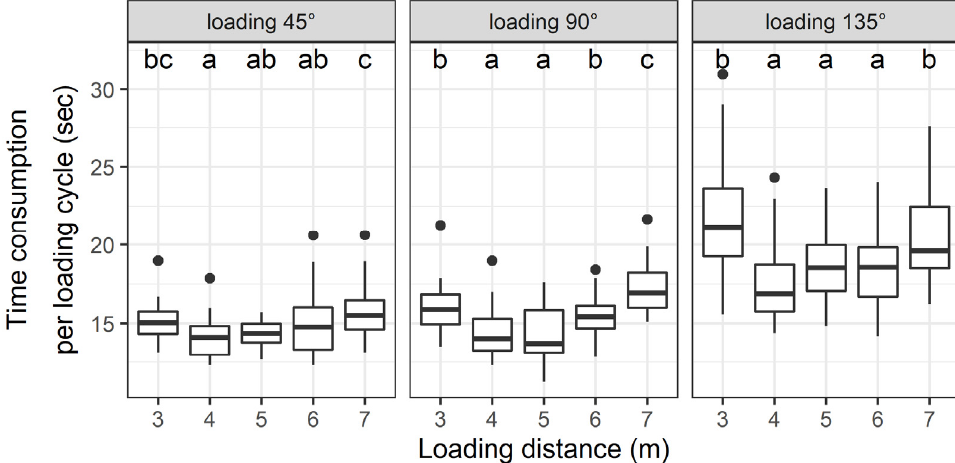
Figure 4. Boxplots showing time consumption per loading cycle for five different loading distances ◦ (m) and three different loading angles (°). (m) and three different loading angles (